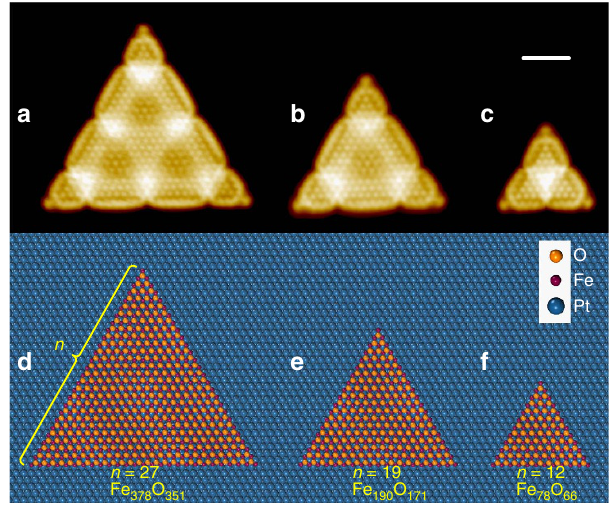
Figure 2 | STM images and the corresponding structural models of equilateral-triangle-shape FeO NSs. In the structural models ( d – f ), the number of Fe atoms along each edge of the FeO triangle is denoted by n . The atomic compositions and structures of three FeO NSs are obtained from STM images ( a – c ). STM images were taken at 5K and scanning parameters are ( a ) V s ¼ þ 6mV, I t ¼ 5.5nA; ( b ) V s ¼ þ 7mV, I t ¼ 5.9nA; and ( c )